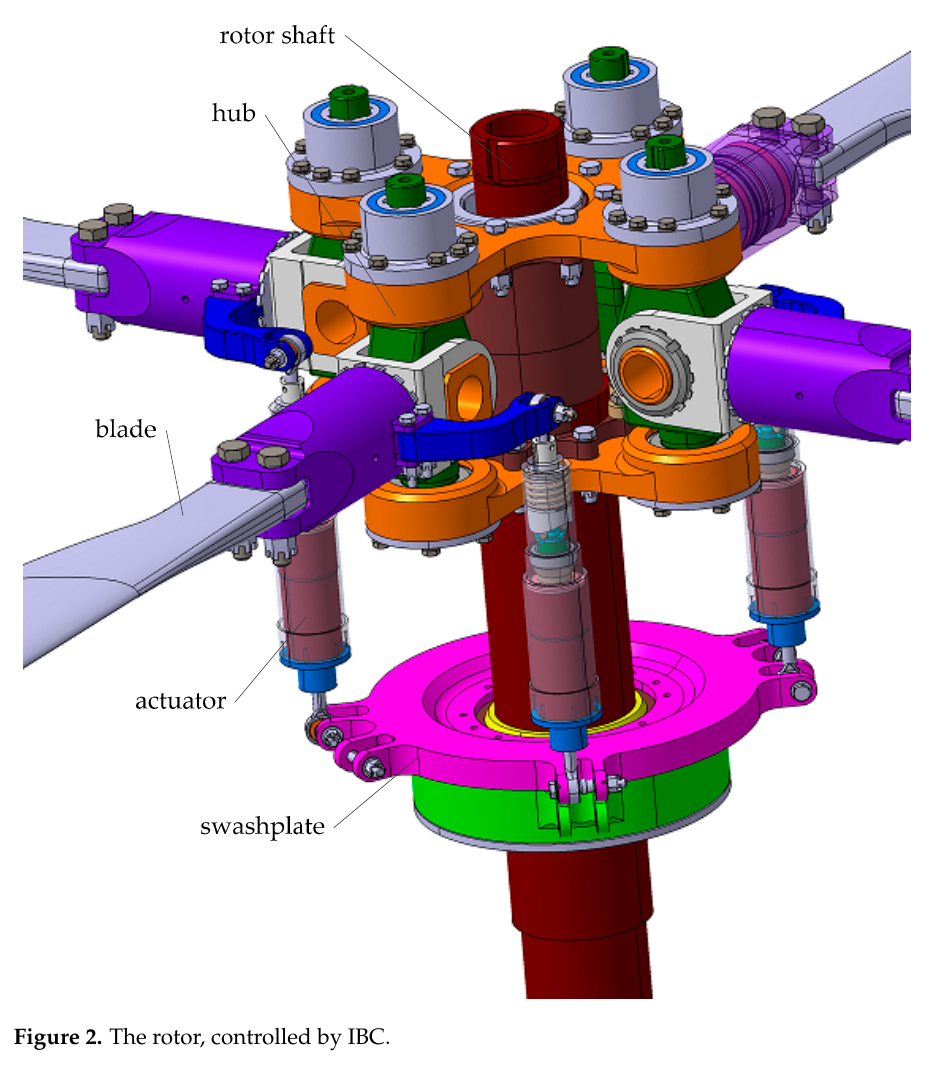
Figure 2. The rotor, controlled by IBC.